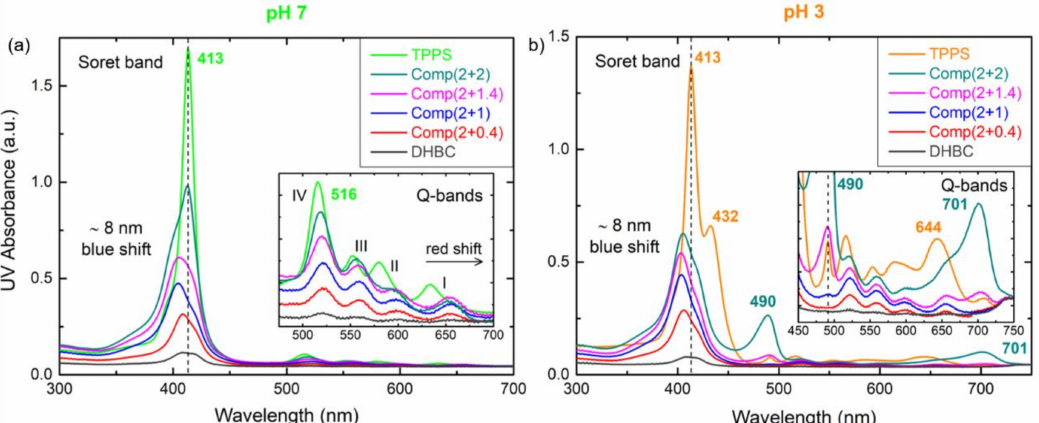
Figure 4. UV-vis spectra of the DHBC/TPPS complex solutions at pH ( a ) 7 and ( b ) 3. The insets show a scaling up of the Q-bands area. The corresponding spectra of neat TPPS and DHBC are also included for